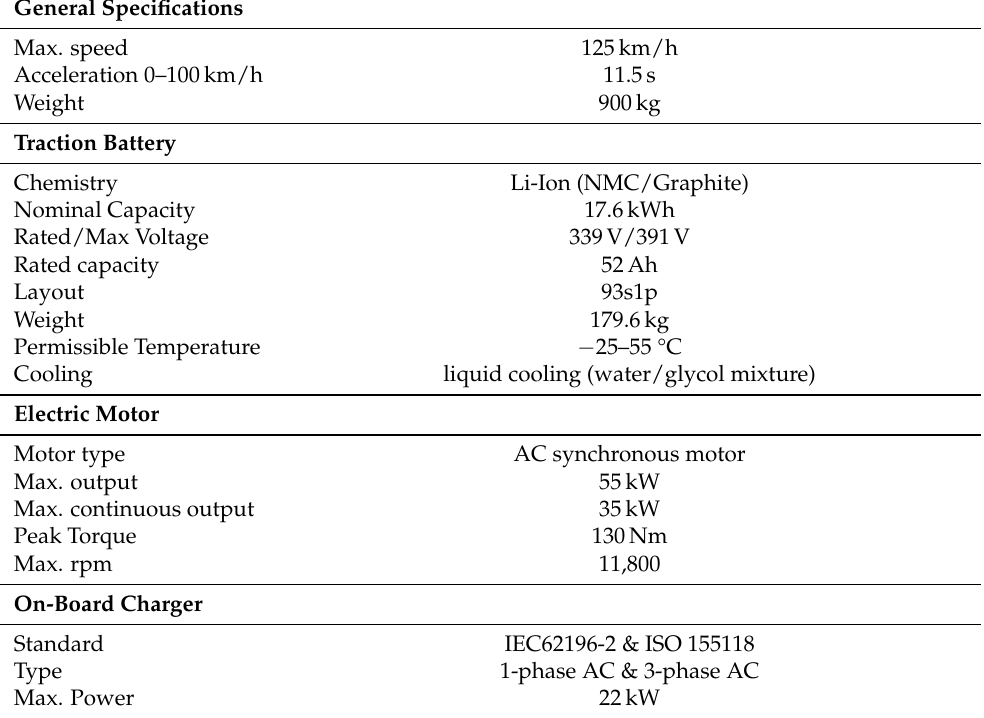
Table 2. Specifications of Smart e.d. (3rd Generation)